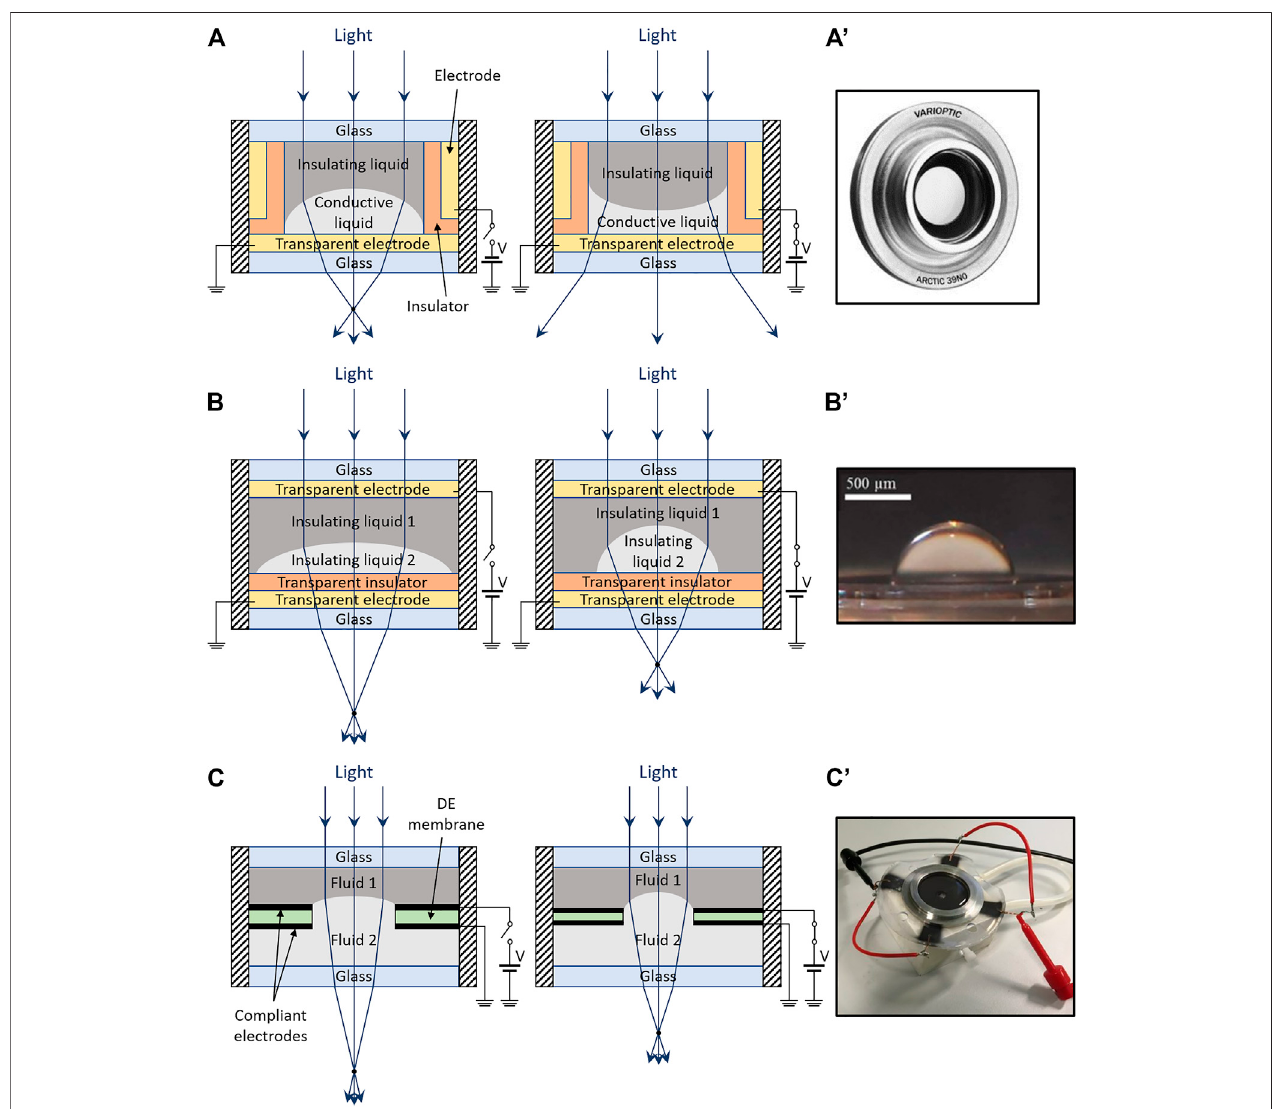
FIGURE 3 | Electrically or electro-mechanically shaped meniscus lenses. Structures and principles of operation (left) and photos of examples (right) , for different actuation strategies: (A) schematic of an electrowetting lens (example among various alternatives), where an applied electric fi eld changes the contact angle of a conductive liquid droplet; (A 9 ) commercial product by Corning Varioptic, adapted from (Varioptic, 2021); (B) schematic of a dielectrophoretic lens (example among various alternatives), where an applied electric fi eld changes the contact angle of an insulating liquid droplet; (B 9 ) prototype sample, reproduced with permission from (Almoallem and Jiang, 2017); (C) schematic of an electro-mechanically controlled meniscus lens, where the curvature of a meniscus is changed by an electrically induced deformation of an annular DE actuator; (C 9 ) prototype sample, reproduced with permission from (Rasti et al., 2015b).